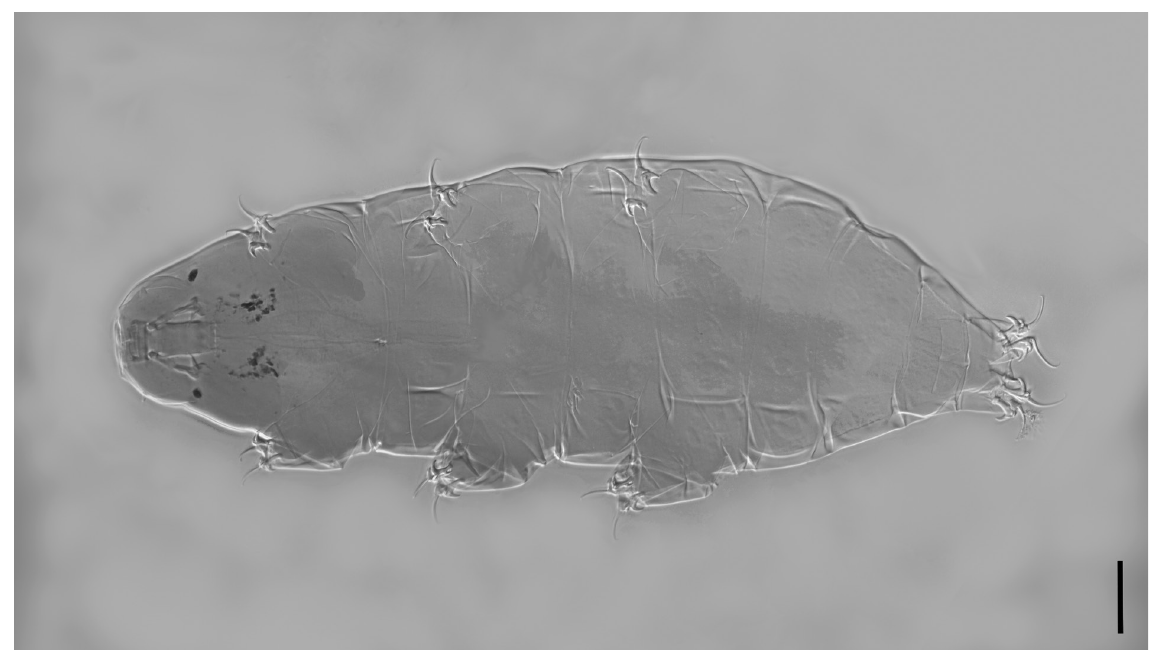
Fig. 13. Milnesium irenae sp. nov., holotype, ♀ (slide No. UNLPam 1657-1). Habitus. Scale bar = 50 µm.